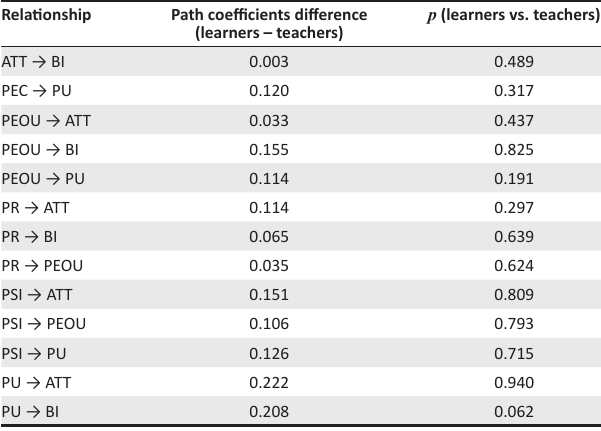
FIGURE 2: Teachers’ and learners’ m-learning acceptance structural TABLE 4: Multigroup analysis partial least squares results. Relationship